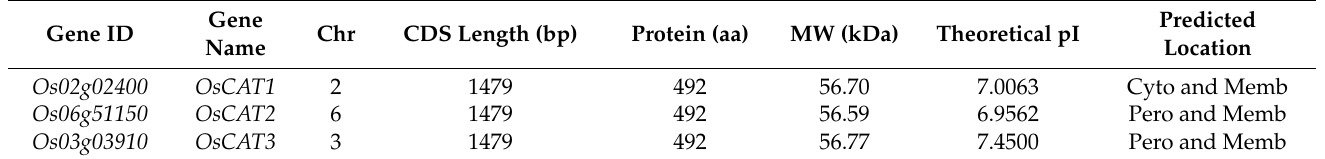
Table 1. CAT gene and coding protein information.